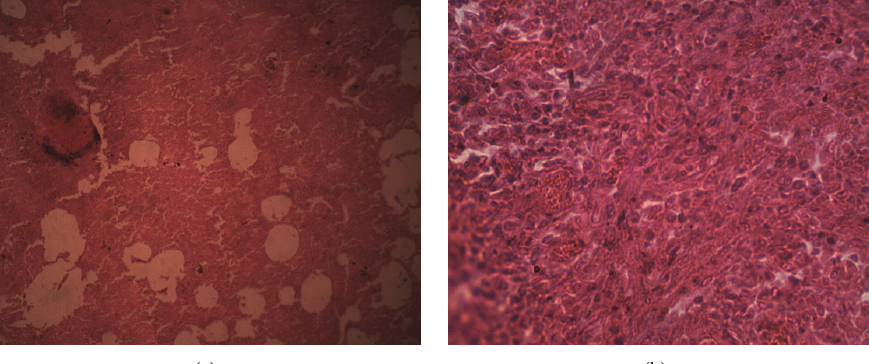
Figure 4: The micrograph in section (a) shows the lioness lungs with extensive alveolar collapse and multiple foci of granulomatous reactions inthelungs, × 100H&E.(b)Highermagnificationofsection(a)showingextensivefibrosis,markedalveolarcollapse,andmononuclearcellular infiltrations.